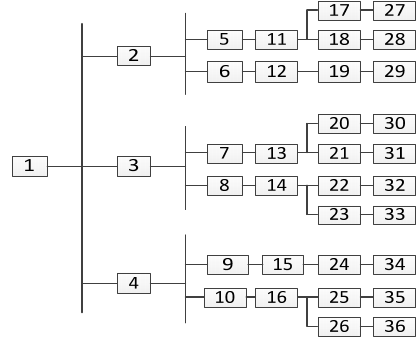
Figure 2. Network topology map of smart meter communication system.